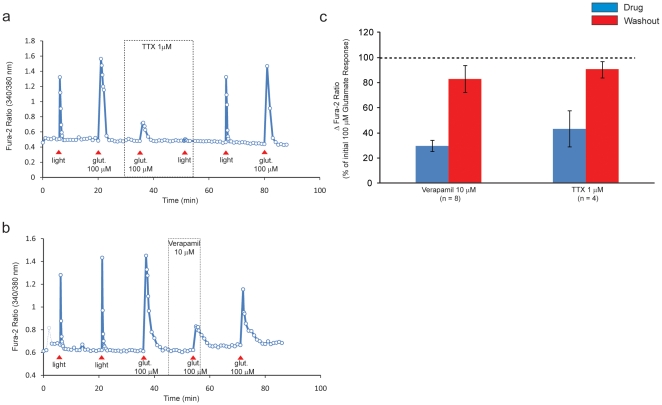
Glutamate-evoked Ca2+ responses in ipRGCs in the absence and presence of tetrodotoxin or verapamil.(a) The glutamate-evoked (Glut 100 µM) Ca2+ response in an isolated ipRGC was reversibly inhibited by tetrodotoxin (TTX, 1 µM) and the light-evoked rise in [Ca2+]i was completely blocked. (b) The glutamate-evoked increase in [Ca2+]i was reversibly inhibited by verapamil (10 µM). (c) Summary (means ± SEM, normalized to the pretreatment responses) demonstrating reversible inhibition of the glutamate-evoked rise in [Ca2+]i by tetrodotoxin (n = 4) and verapamil (n = 8). p<0.01, one-way repeated measures ANOVA, Tukey's post-hoc test compared to initial and recovery responses for TTX and verapamil.